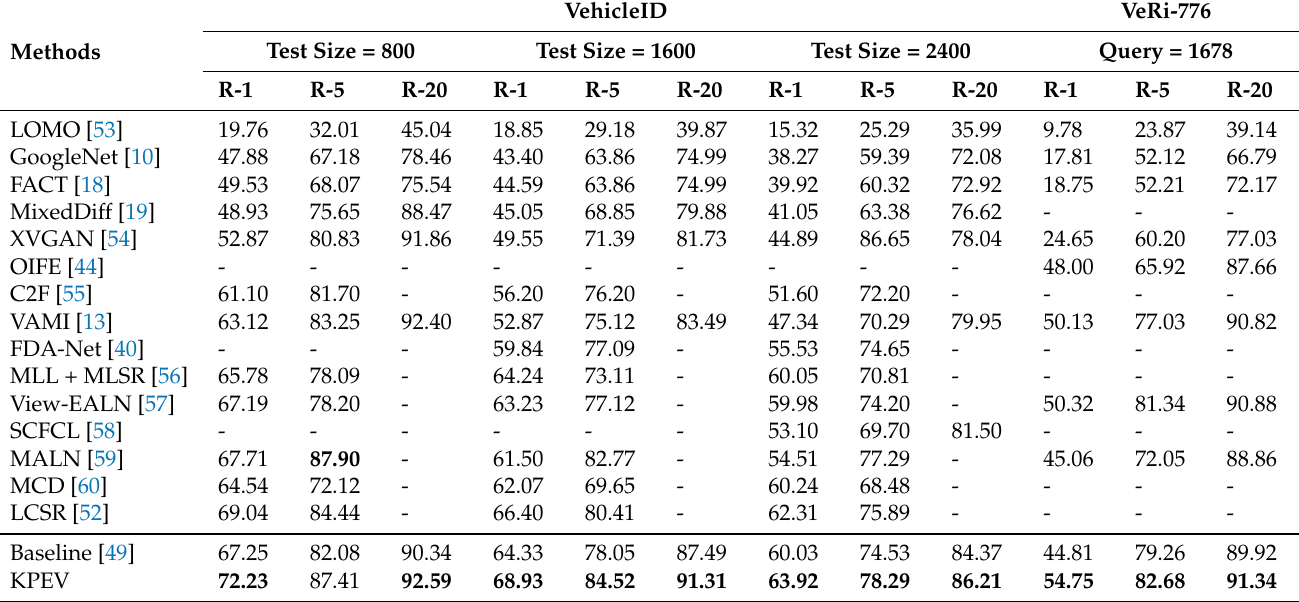
Table 6. Comparison (%) of vehicle Re-ID performance of visual models on the VehicleID dataset. The best results are shown in